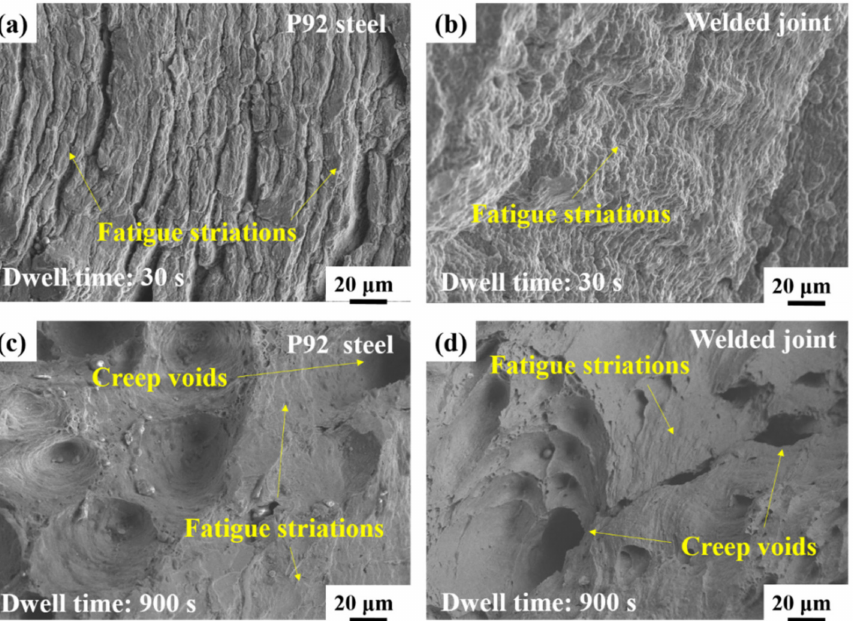
Figure 10. Fractographies of the BM specimens under creep-fatigue loading with ( a ); short and ( c ) long holding times. Fractographies of the welded specimens under creep-fatigue loading with ( b ) short and ( d ) long holding